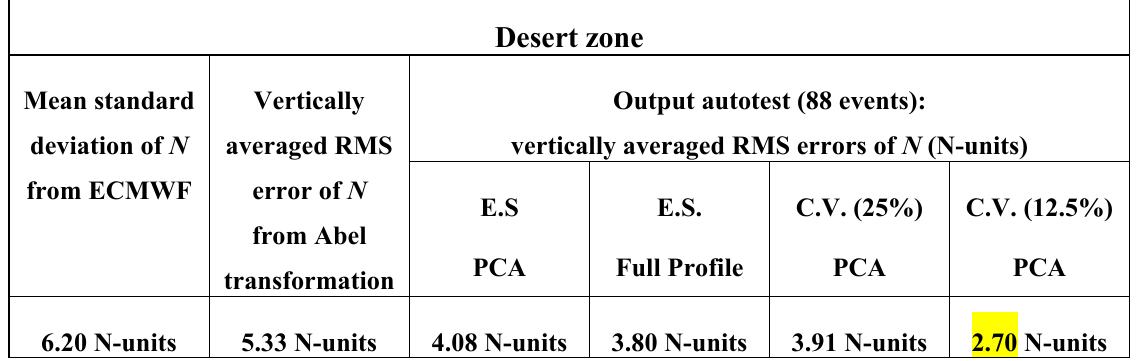
Table 3. Desert zone: mean standard deviation of ECMWF refractivity N , vertically averaged RMS error of refractivity N from Abel transformation and vertically averaged RMS error of refractivity N as output of neural network autotest (88 events) using the different approaches. E.S.: Early Stopping; C.V.: Cross Validation. The best result is highlighted.